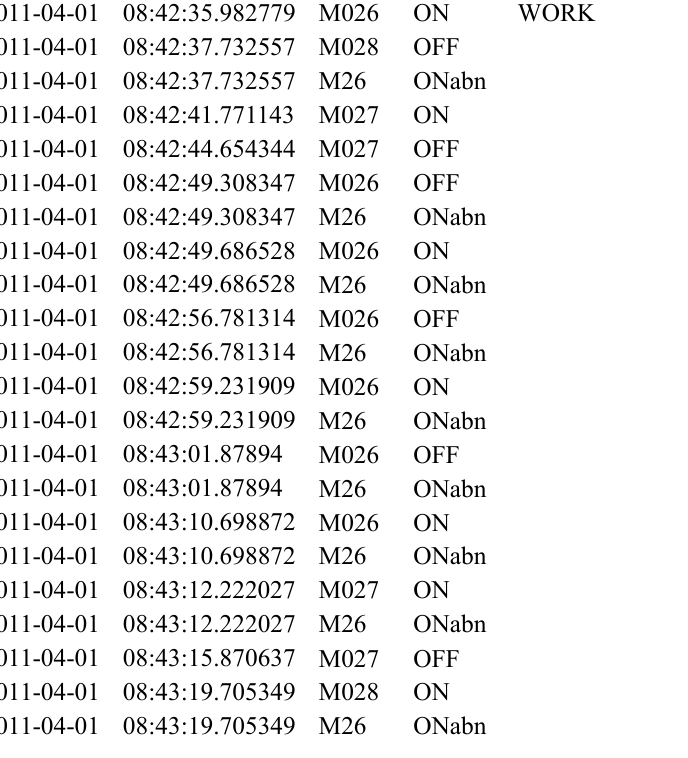
Figure 2. A snapshot for sub-activity-related anomaly synthesis. ONabn shows the inserted sen- sor